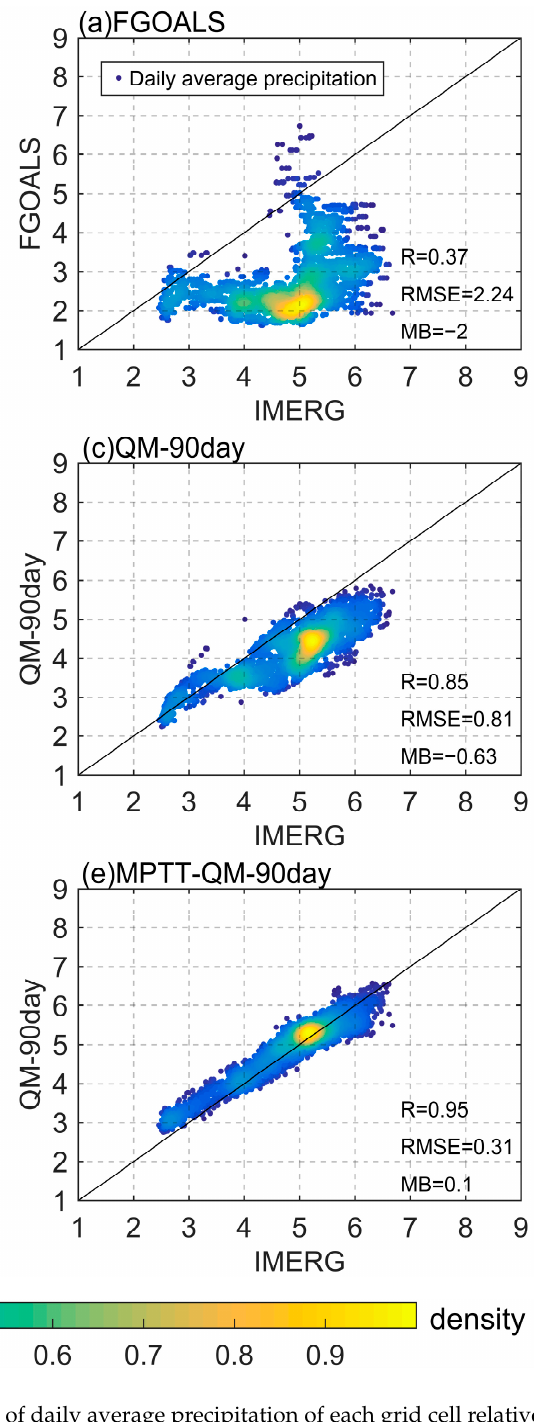
Figure 4. Density scatter diagram of daily average precipitation of each grid cell relative to IMERG in the PRB from 2016 to 2020. Each scatter point represents the daily average precipitation value of each grid cell in the study area, the color bar represents the density of precipitation values. and ( a – e ) represent the FGOALS, QM-14day, QM-90day, MPTT-QM-14day, and MPTT-QM-90day, respectively (unit: mm/day).